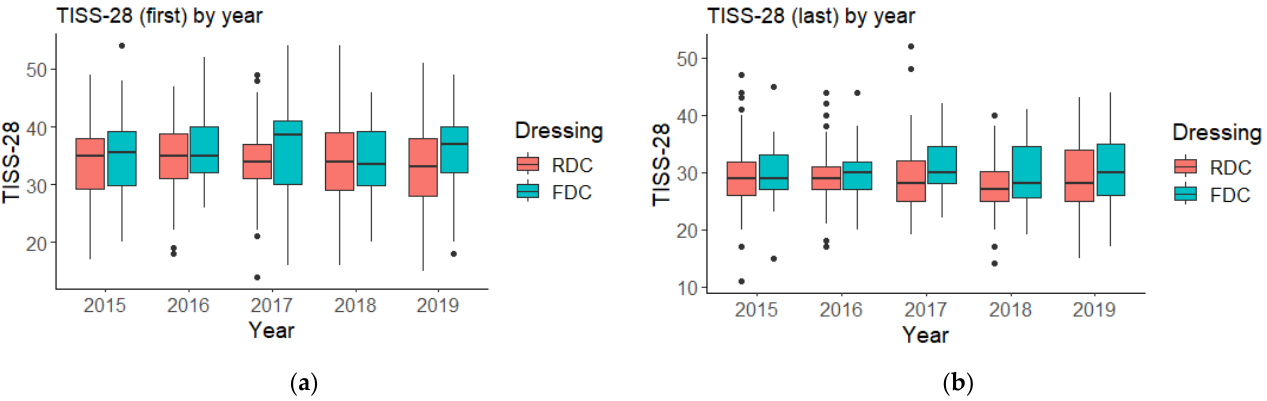
Figure 1. TISS-28 (first) ( a ) and TISS-28 (last) ( b ) by year, cluster by type of wound dressing changes (routine dressing changes (RDC) vs. frequent dressing changes (FDC)). (routine dressing changes (RDC) vs. frequent dressing changes